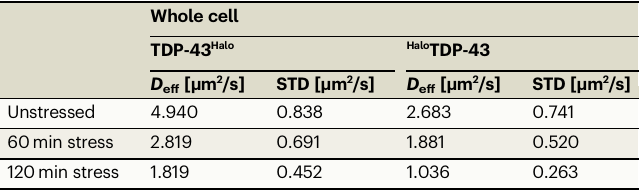
Table 1 | Comparison of the effective diffusion coef fi cient D eff between TDP-43 Halo and Halo TDP-43 constructs at different stress durations (unstressed, 60 min and 120 min 0.5 mM incubation with sodium arsenite, error given as the standard deviation